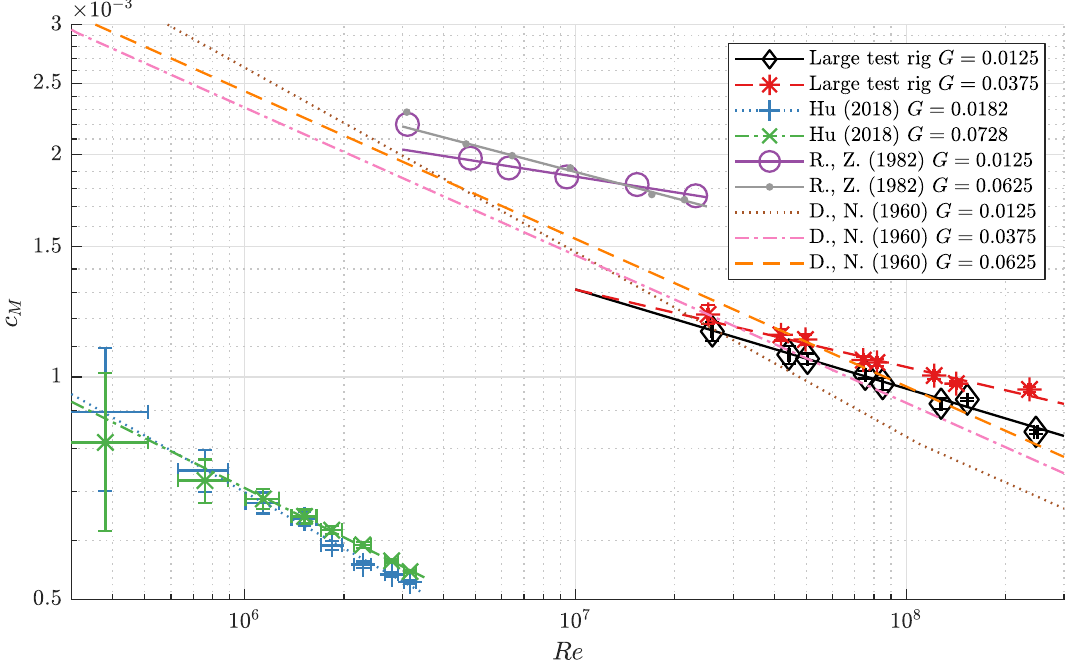
Figure 2. Measured torque coefficients (see Equation (7)) of closed rotor–stator cavities with hydraulically smooth disc. The lines belonging to measurement points are best curve fits. “Hu (2018)” refers to [10], “R., Z. (1982)” to [3], and “D., N. (1960)” to